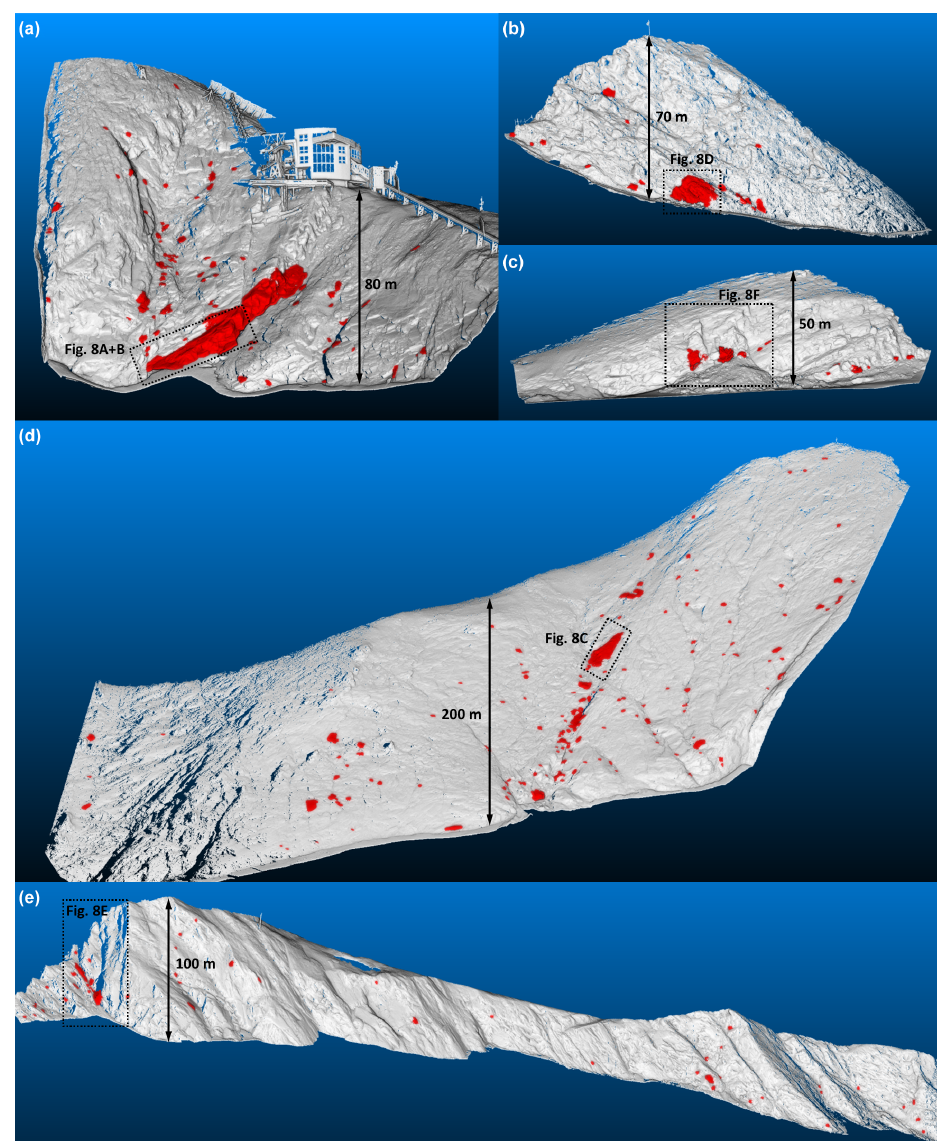
Figure 7. Frontal views of monitored rockwalls. Rockfall source areas identified during the 6-year monitoring period are indicated in red. (a) KN; (b) MKE; (c) MKW; (d) KNW; (e) MGE. Displayed topography and glacier level were taken from the most recent lidar survey (i.e. from 2016 for MKW and from 2017 for all other